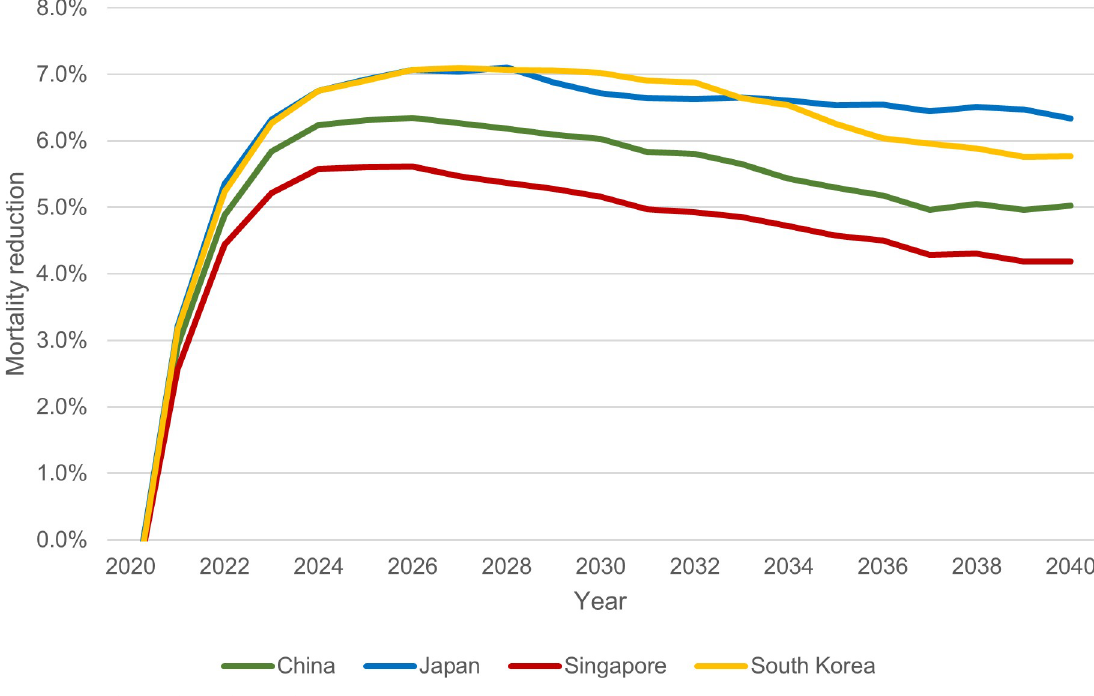
Fig 6. Annual mortality reduction by year, 2020–2040.